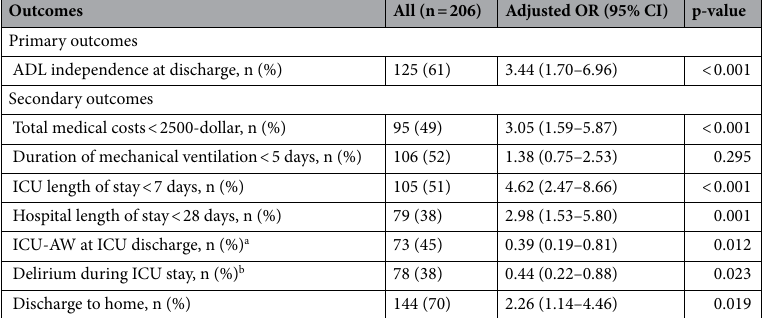
Table 2. Multivariable logistic regression analysis of the association between early mobilization achievement and outcomes. Variables for the outcomes in the multivariable logistic regression included age, Barthel index before hospitalization, planned operation, Sepsis shock at ICU admission, APACHE II score, use of continuous vasopressor. OR odds ratio , IQR interquartile range, ADL activity daily living, ICU intensive care unit, APACHE acute physiology and chronic health evaluation, ICU-AW ICU-acquired weakness. a Of 206 patients, 44 were missing. b Of 206 patients, 39 were